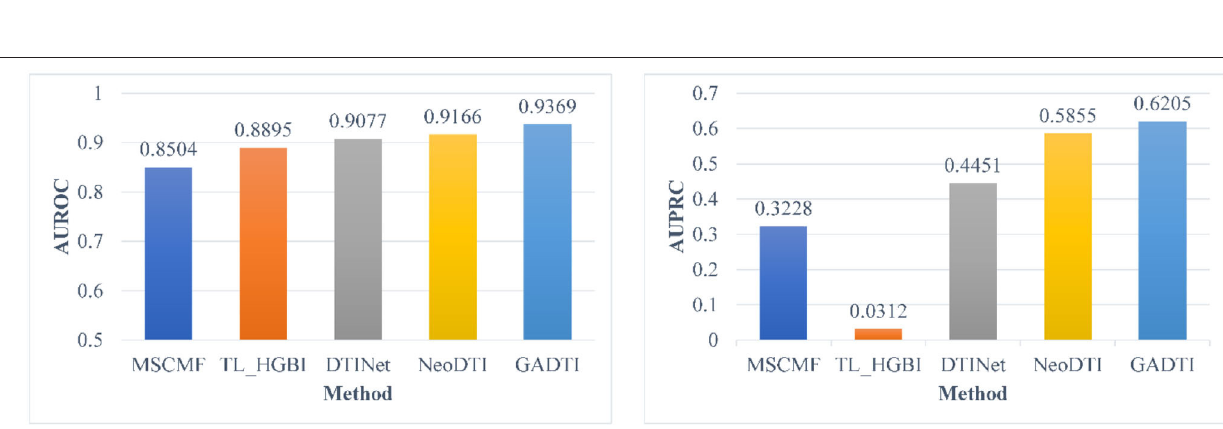
Frontiers in Genetics |